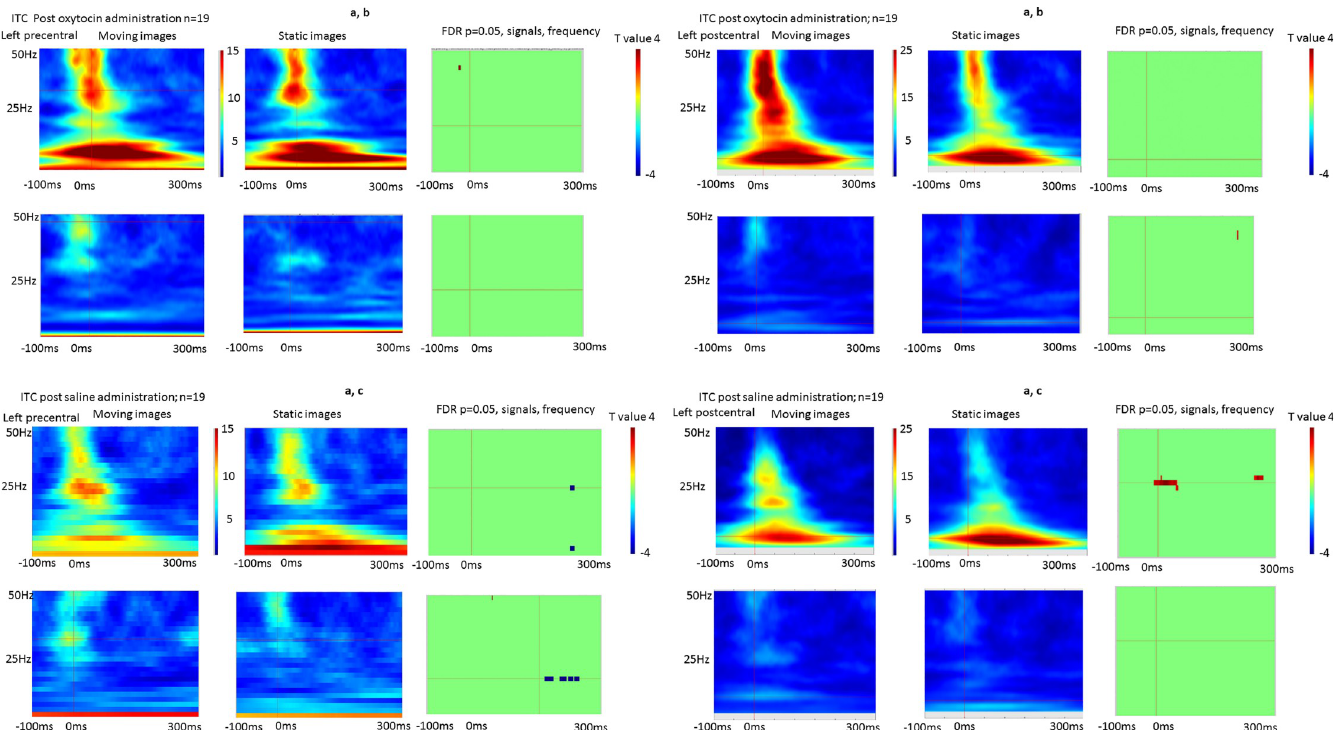
Fig 4. (A) The grand average of the time-frequency maps of Intertrial phase coherence (ITC) during moving and static image observations in the precentral and postcentral gyri after saline or oxytocin administration. (B) T maps of the difference in ITCs between moving and static image observations in the pre and postcentral gyri after oxytocin administration. No significant differences were found in either the precentral or postcentral gyri, when the statistical threshold was set at p < 0.05 with a false discovery rate correction. (C) T maps of the difference in ITCs between moving and static image observations in the precentral and postcentral gyri after saline administration. Significantly lower ITCs were observed in the right precentral gyrus, whereas significantly higher ITCs were observed in the left postcentral gyrus, when the threshold was set at p < 0.05 with a false discovery rate